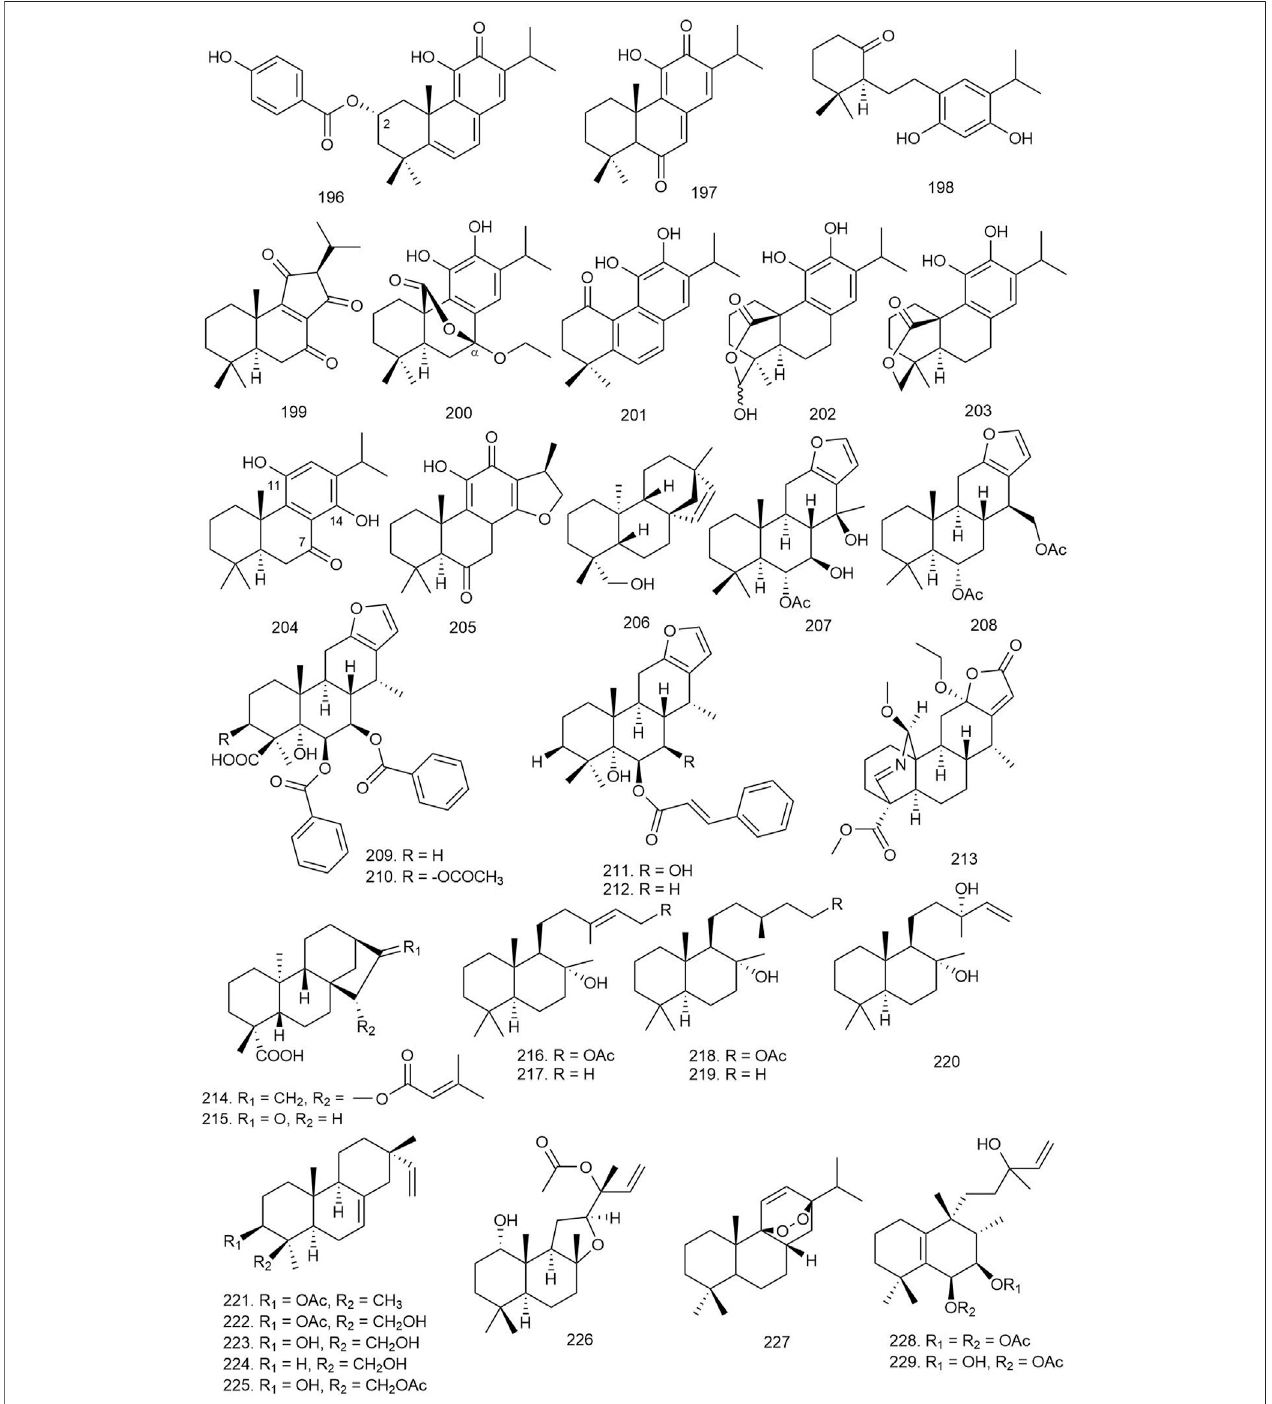
FIGURE 11 | Structures of abietane, beyerene, cassane, kaurene, labdane, pimarane, and miscellaneous diterpenoids with signi fi cant antiprotozoal activity.